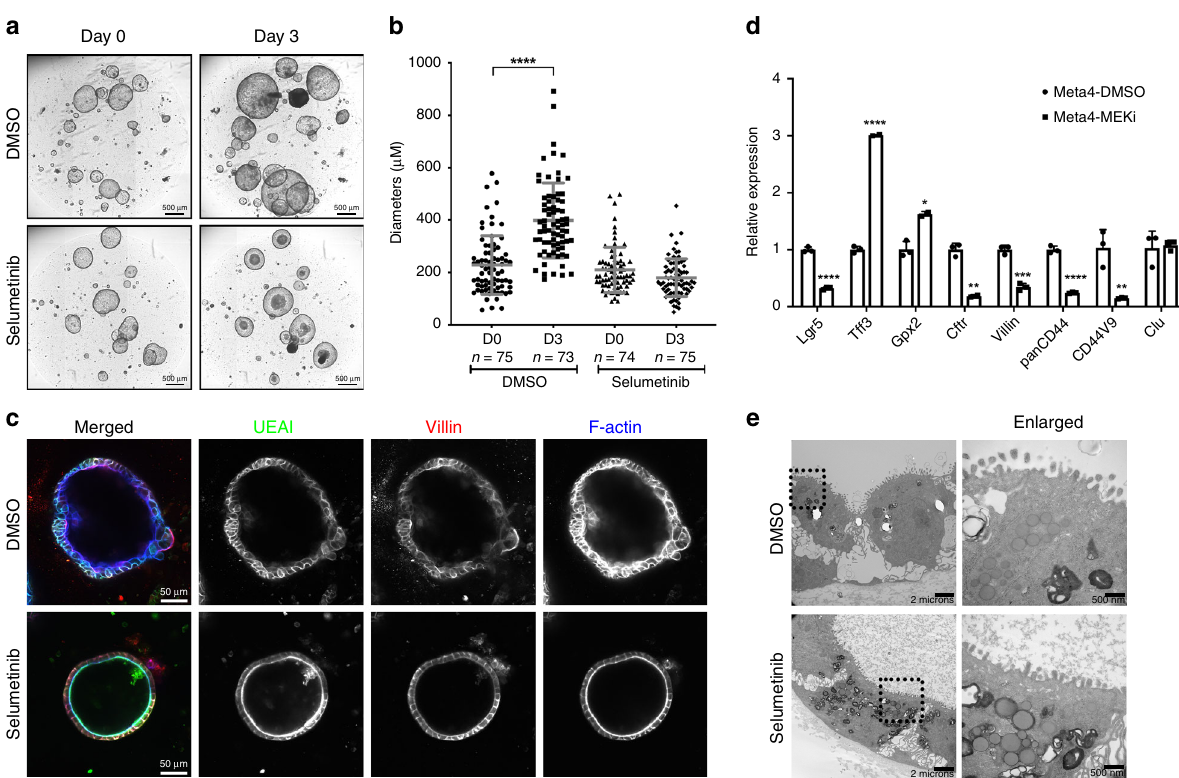
Fig. 4 Examination of cellular changes in Meta4 organoids after MEK inhibition. a Meta4 organoids were treated with either DMSO containing control media or Selumetinib (1 μ M) containing media for 3 days. Phase contrast images were captured before and 3 days after the DMSO vehicle or Selumetinib treatment. Scale bars indicate 500 μ m. b Diameters of Meta4 organoids were manually measured before and after either DMSO vehicle or Selumetinib treatment. Data are presented as mean values with standard deviation. P -values were calculated using unpaired two-tailed t -test. **** P < 0.0001. c Co- immunostaining for markers of enterocyte apical membrane, UEAI, Villin and F-actin in paraf fi n sections of Meta4 treated with either DMSO vehicle or Selumetinib. Scale bars indicate 50 μ m. d Expression of intestinal lineage marker transcripts after Selumetinib treatment. Quantitative PCR showing relative expression of intestinal lineage marker genes ( Lgr5, Lys, Tff3, Cdx1, Cdx2, Gpx2, Ctfr, Villin , and Muc2 ), a CSC marker (pan CD44 ) and metaplasia markers ( CD44v9 and Clu ) 3 days after Selumetinib treatment. Lys, Cdx1, Cdx2 , and Muc2 were not detected. Data are presented as mean values with standard deviation ( n = 3). P -values were calculated using unpaired two-tailed t -test. * P < 0.05 (0.01; Gpx2), ** P < 0.005 (0.002; Cftr, 0.009; CD44v9), *** P